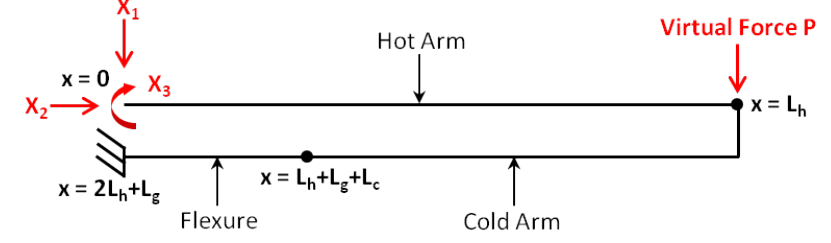
Figure 8. The simplified plane rigid frame for the thermal actuator structure showing the three redundants X 1 , X 2 and X 3 . The virtual force P applied at the free end of the actuator as part of the force method is also